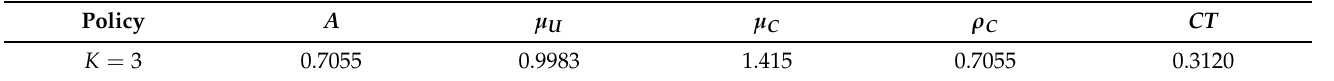
Table 2. Peformance measures and costs by cycle for K =